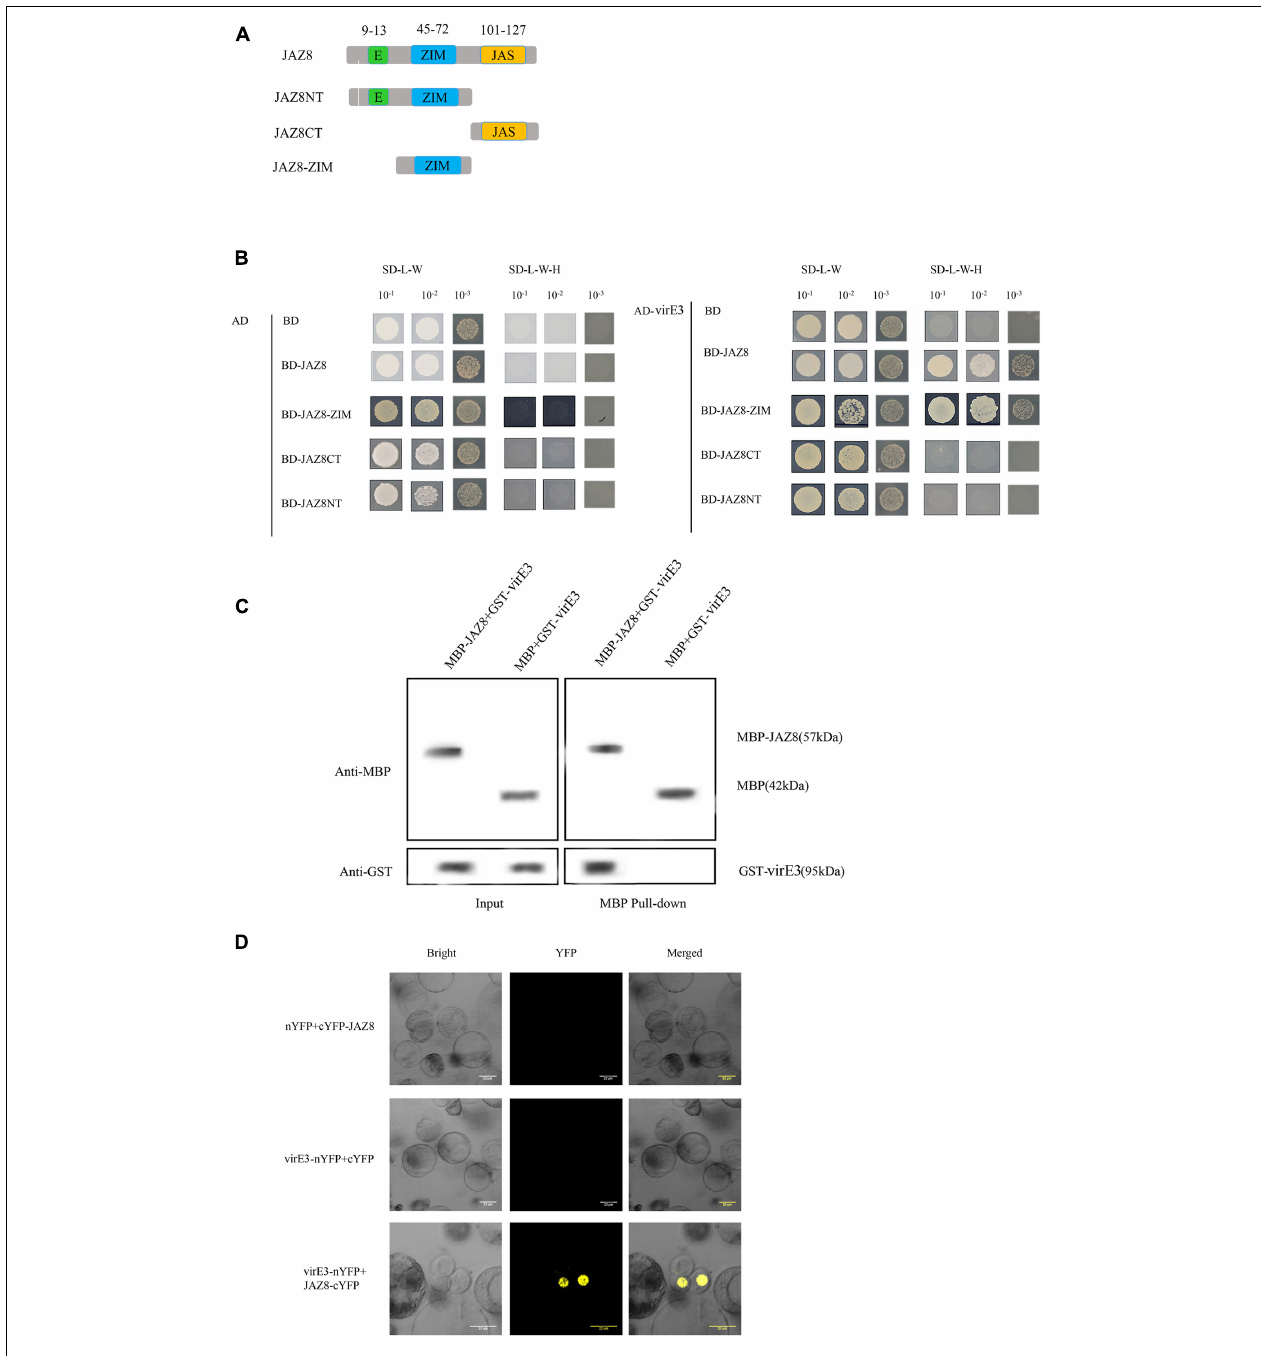
FIGURE 1 | VirE3 interacts with AtJAZ8 in vivo and in vitro. (A) Schematic representation of JAZ8 constructs used for yeast two-hybrid assay. Numbers represent amino acid positions in full-length JAZ8. (B) Yeast two-hybrid assay. Full length of JAZ8 and the truncated fragments of JAZ8NT (aa 1–101), JAZ8CT (aa 101–127), JAZ8-ZIM (aa 13–101) were cloned into pAS2.1 (BD). The virE3 was cloned into pACT2 (AD). The indicated prey and bait constructs were cotransformed into yeast strain PJ69-4A. The transformants were first screened on synthetic defined (SD) medium minus tryptophan and leucine (SD/-Trp-Leu) and the positive yeast cells were subcultured on SD medium minus tryptophan, leucine and histidine at 30 ◦ C for 4 days. pAS2.1 and pACT2 were used as the negative control. (C) Maltose-binding protein (MBP) pulldown assay. The MBP pull-down proteins were detected by Western blotting (WB) using anti-GST or anti-MBP antibody. MBP alone was used as the negative control. Input, protein samples without pull-down were analyzed by Western blotting. (D) Bimolecular fluorescence complementation (BIFC) assay. The constructs 35S::VirE3-nYFP and 35S::AtJAZ8-cYFP were transiently co-transformed into Arabidopsis protoplast and the transformed cells were observed under a confocal microscope. 35S::nYFP and 35S:: cYFP were used as negative control.